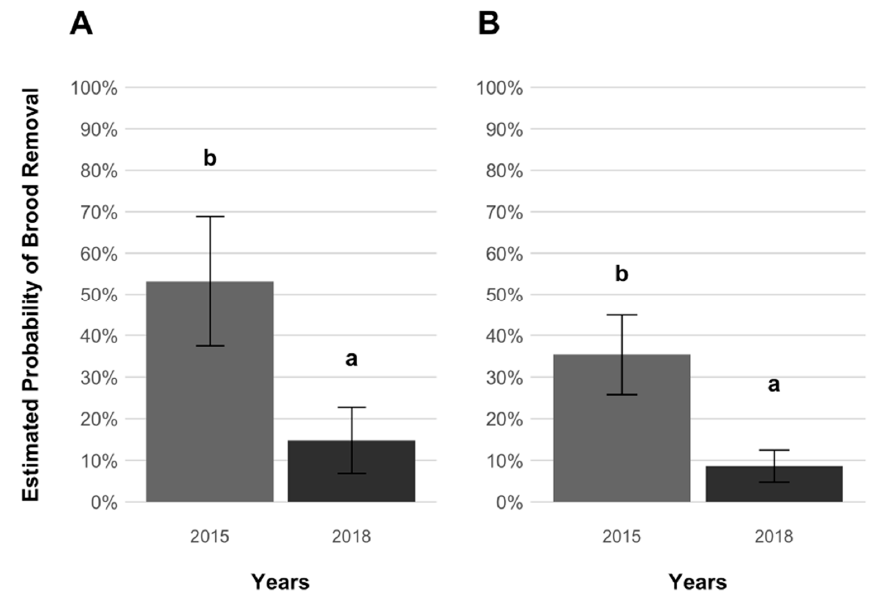
Figure 5. Temporal comparison of the estimated probabilities of worker brood removal ( ± SE) in selected ( A ) and treated ( B ) groups of Apis mellifera cells experimentally infested with Varroa destructor mites associated with treated colonies. Earlier data (2015; Panziera et al. [20]) are indicated in light grey and present data (2018) in dark grey. The earlier data refer to the groups AWD (treated-selected) and C (treated-treated) as reported in Panziera et al. [20]. Significant differences were detected when comparing the probabilities of brood removal across time for both host groups as indicated by different letters ( p = 0.035 and p = 0.006,